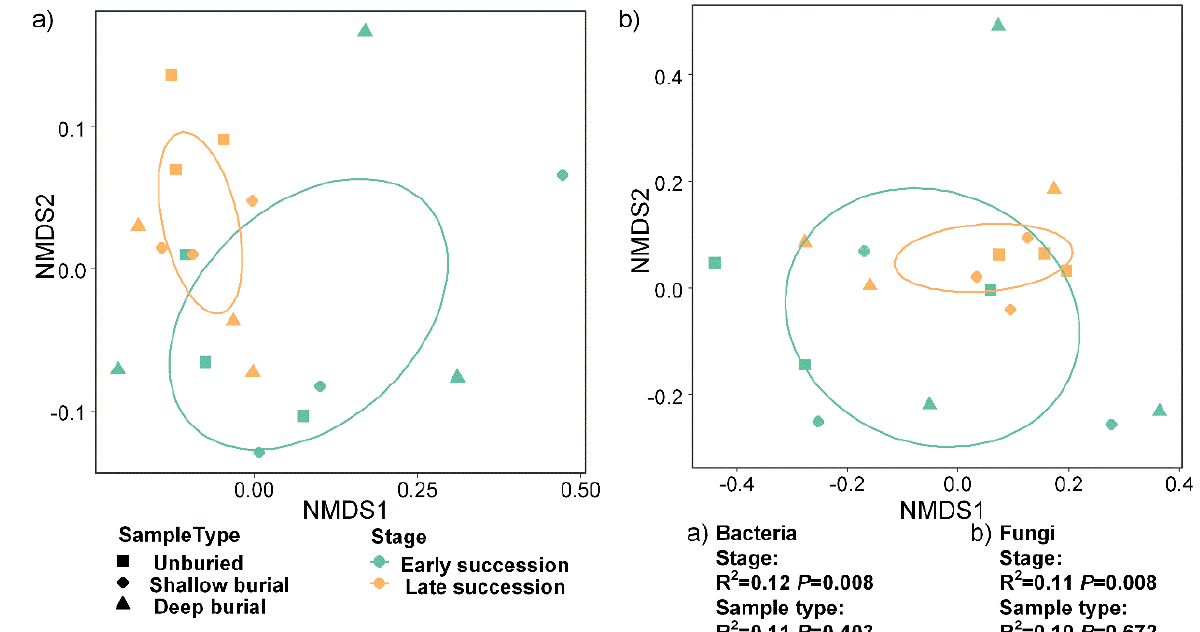
Figure 4. NMDS ordination of the bacterial ( a ) and fungal ( b ) communities.